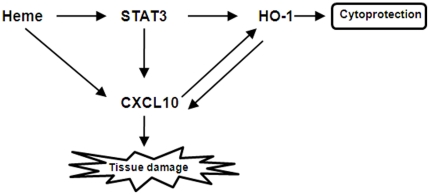
Schematic model for the regulation of Heme/HO-1, CXCL10 and STAT3.1) Heme induced HO-1 and CXCL10 production, 2) Heme induced HO-1 and CXCL10 expression through STAT3 activation, 3) A mutual signaling regulation loop exists between HO-1 and CXCL10.